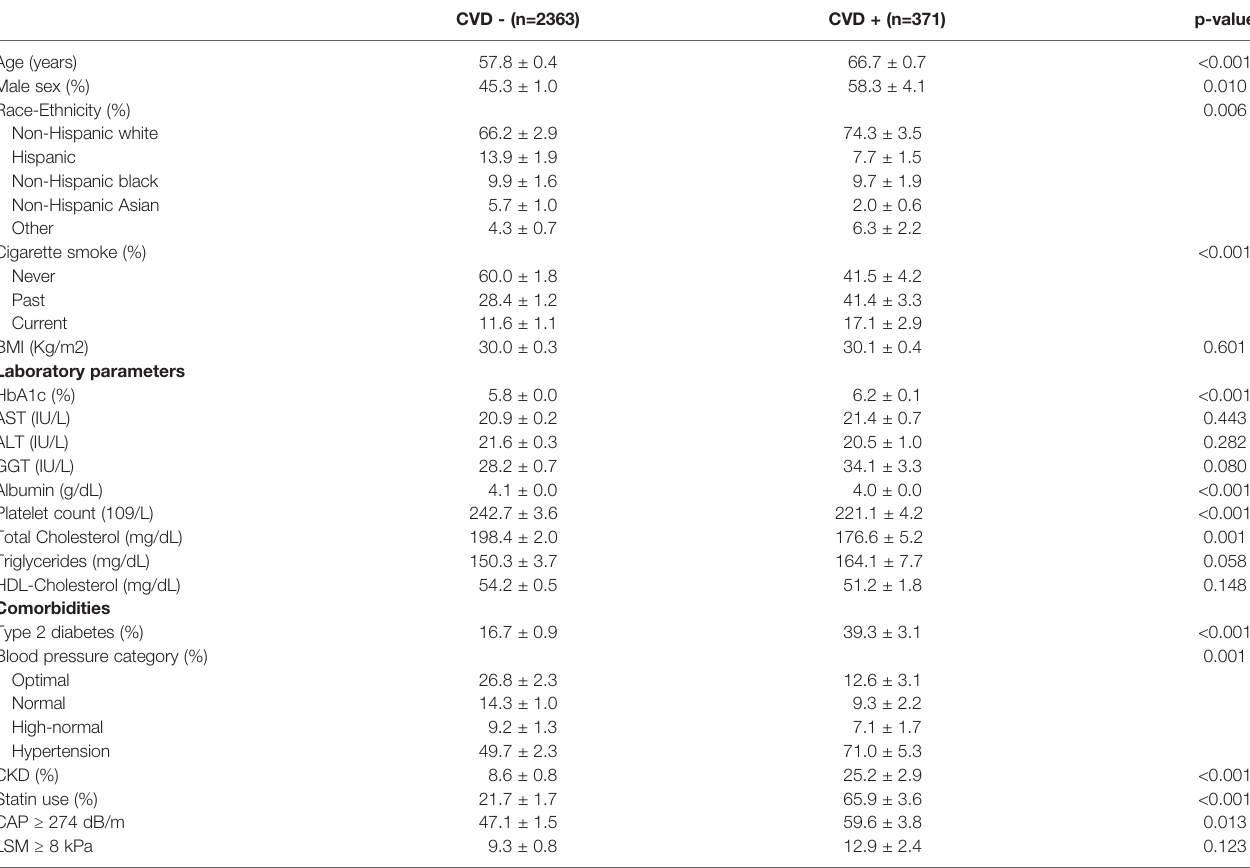
TABLE 3 | Features of the study population according to the presence of cardiovascular disease (CVD).